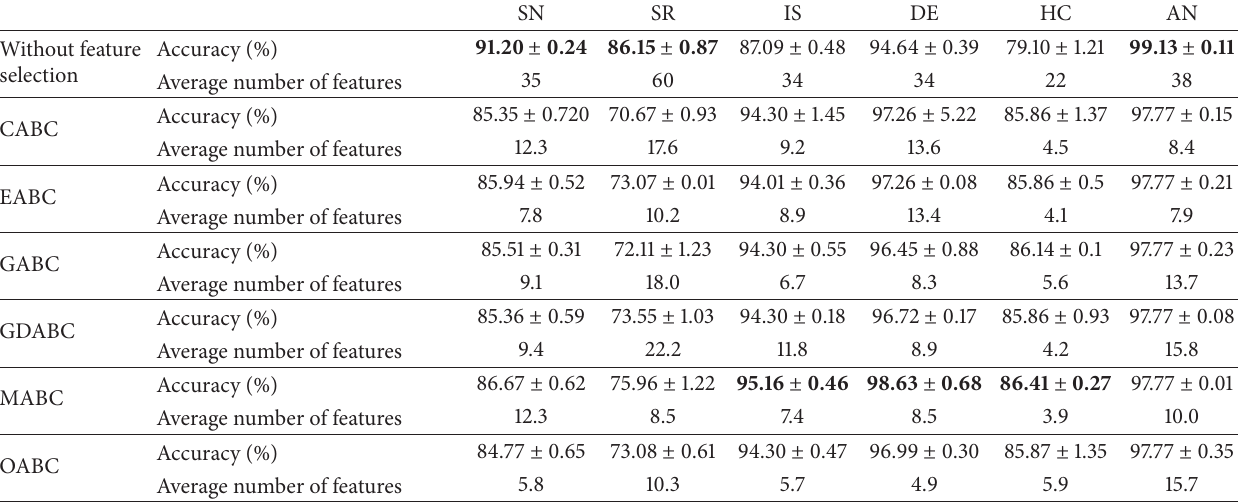
Table 3: Classification accuracy of each ABC algorithm on the tested datasets by using SVM as an induction algorithm. SN SR IS DE HC